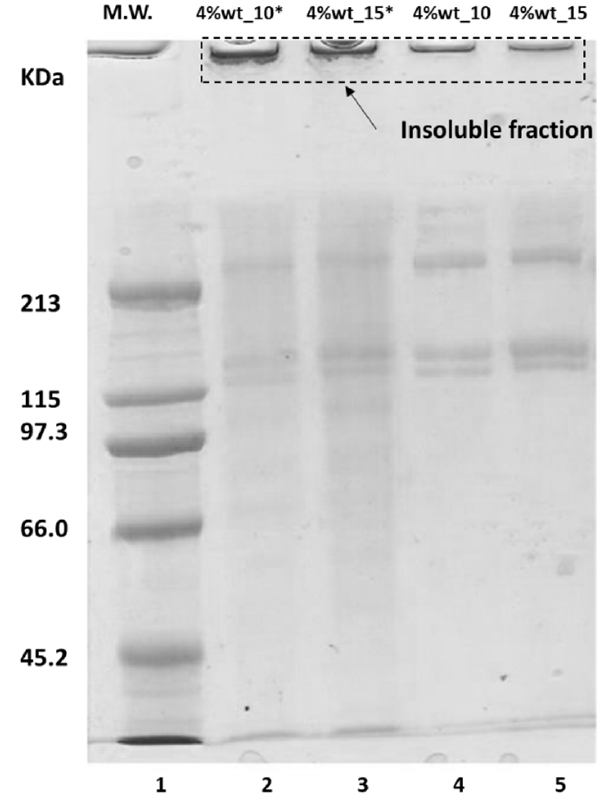
Figure 8. Electrophoresis pattern of the samples. 1: molecular weight standard; 2 (sample 4% wt_10*): 2 mg/mL (sample previously lyophilized and resuspended in 0.1 N acetic acid); 3 (sample 4% wt_15*): 2 mg/mL (sample previously lyophilized and resuspended in 0.1 N acetic acid); 4 (sample 4% wt_10): sample directly resuspended in sample buffer (29 mg/mL); and 5 (sample 4% wt_15): sample directly resuspended in sample buffer (29 mg/mL) .